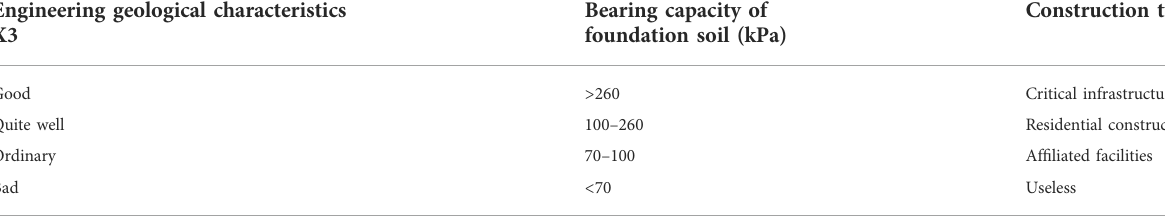
TABLE 4 The engineering geological characteristics and construction type.